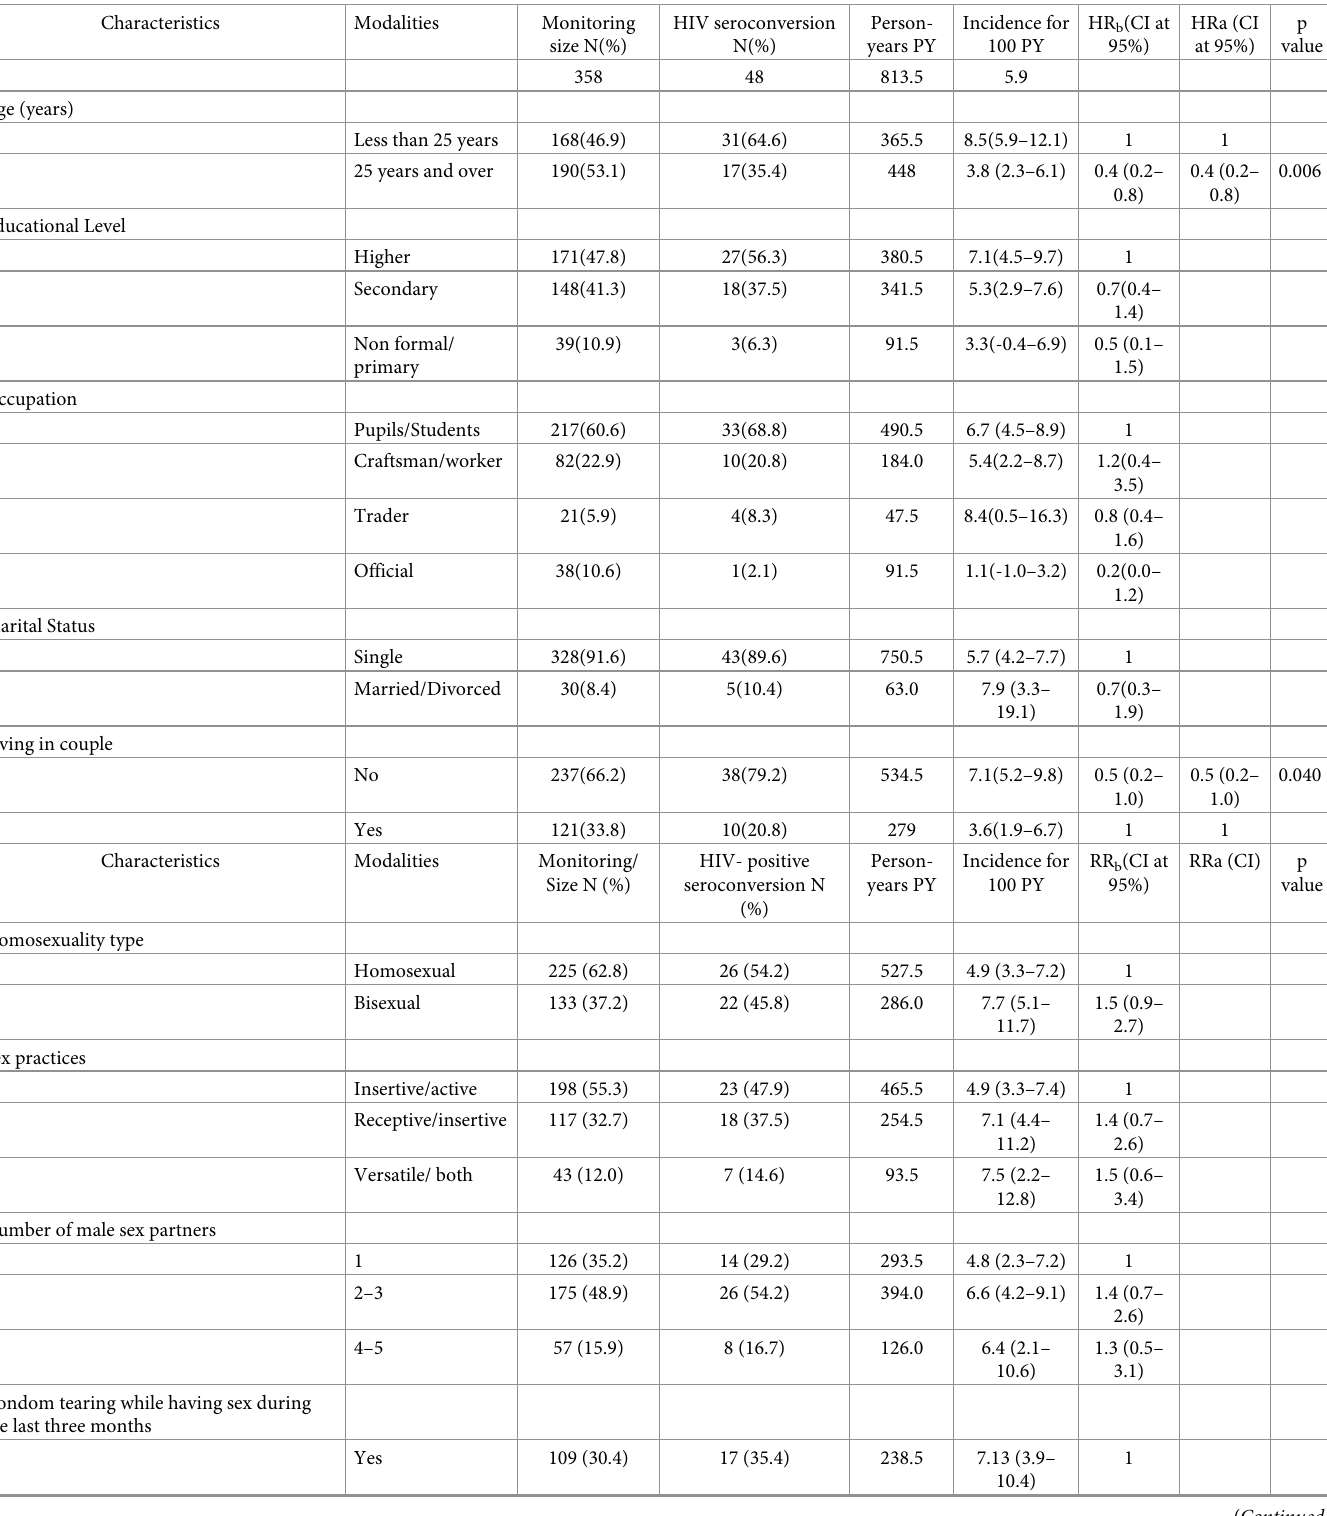
Table 3. Estimated incidence of HIV infection by socio-demographic characteristics and risk factors among men who have sex with men during the 5 semesters of cohort follow-up Benin